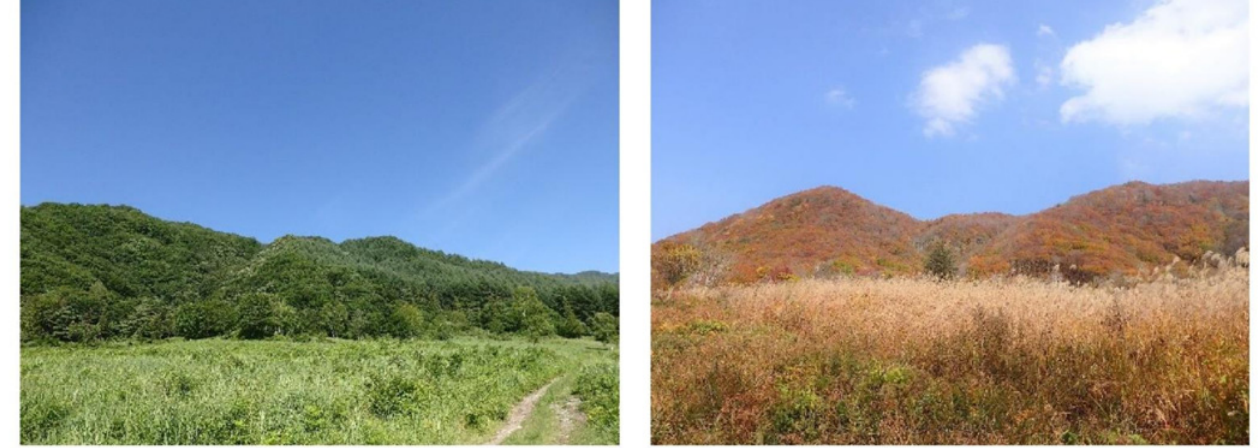
Figure 2. Image showing Uenohara. These pictures were taken in 2015.